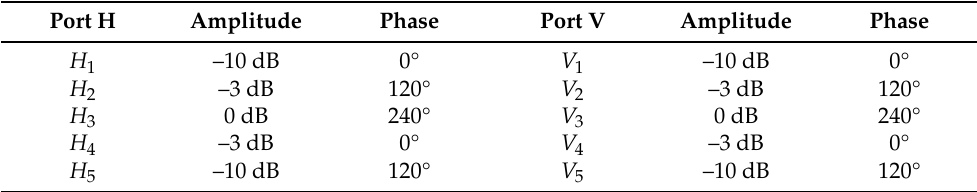
Table 3. Amplitude tapering and phase distribution. Beamforming. Normal array.